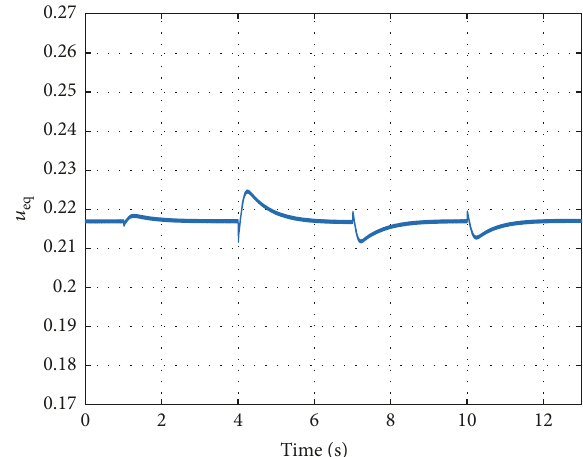
Figure 12: Equivalent control 𝑢